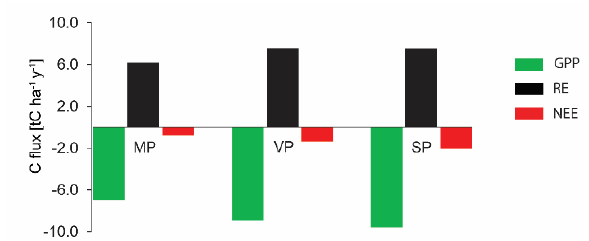
Figure 6. Annual carbon fluxes (tC ha −1 y −1 ) on a catchment scale where MP—Mlynický Creek catchment, VP—Velický Creek catchment, SP—Slavkovský Creek catchment, green bars—GPP, black bars—RE and red bars—NEE. Negative values of NEE indicate carbon sink.